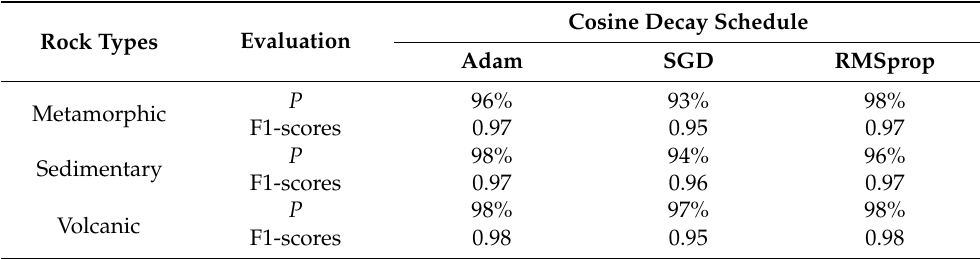
Table 2. Detailed classification results for all rock types.